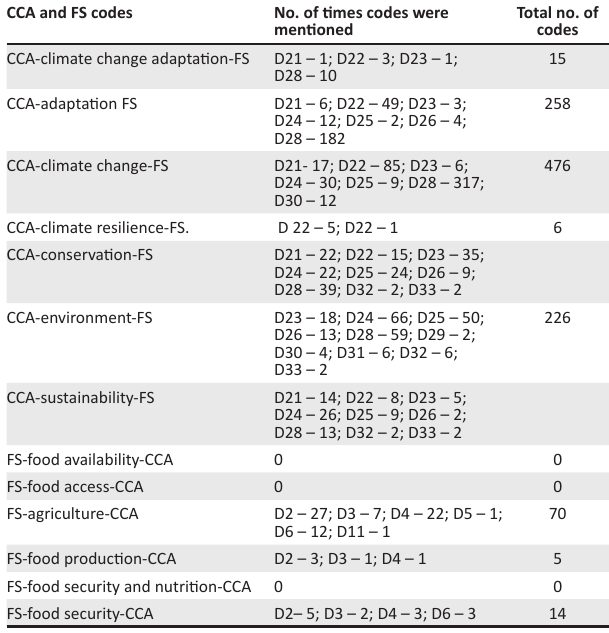
TABLE 4: Interlinkages between climate change adaptation and food security policy and